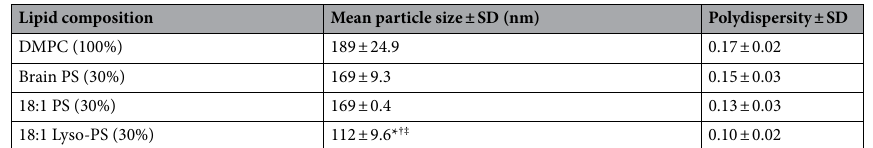
Table 1. Particle size and size distribution of nanoparticles containing different PS species varying in the number of acyl chains. One-way ANOVA followed by Tukey’s post-hoc multiple comparison test were performed to detect significant differences ( P < 0.05). *Significant difference from DMPC. † Significant difference from Brain PS. ‡ Significant difference from 18:1